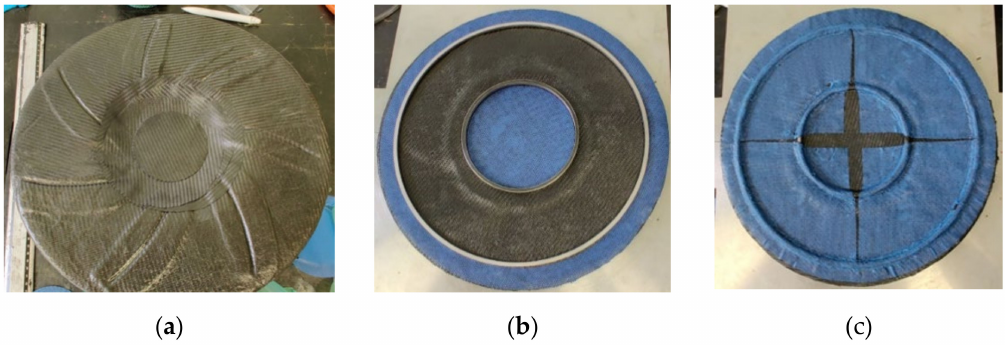
Figure 15. Representations of the composite impeller second manufacturing step: ( a ) composite layers to form the back of the impeller; ( b ) metallic rings for balancing operations; ( c ) composite layers to fix the metallic